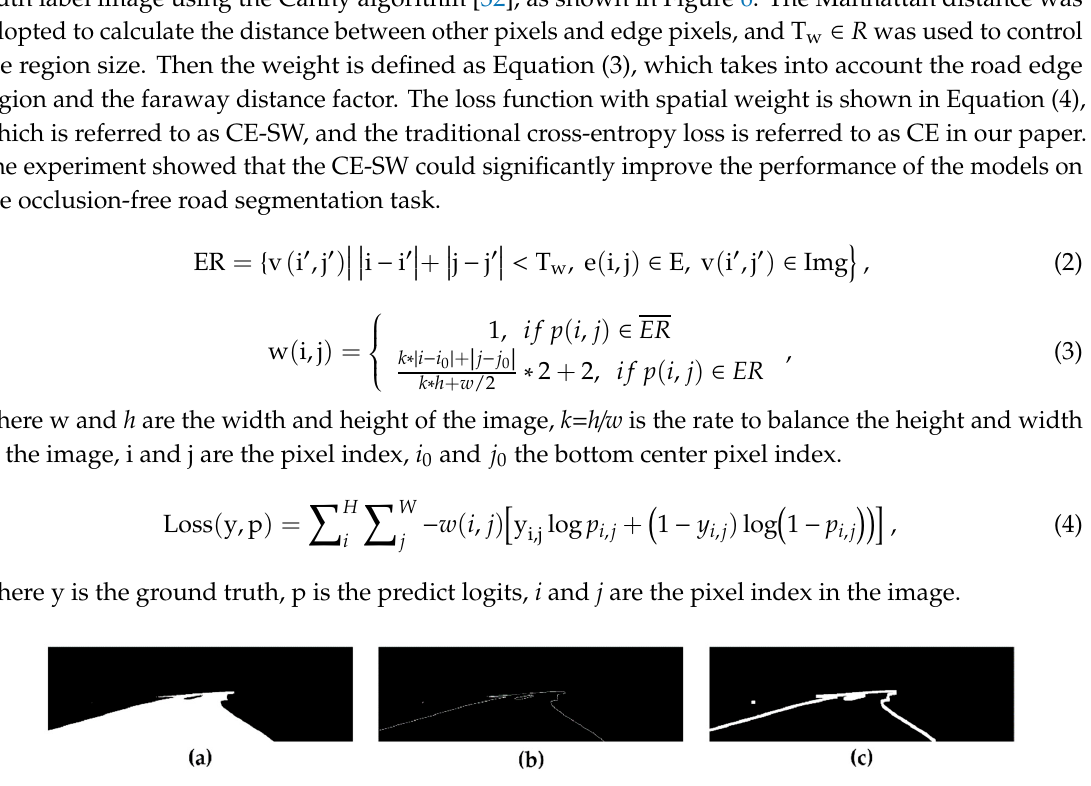
Figure 5. Residual blocks in our network.